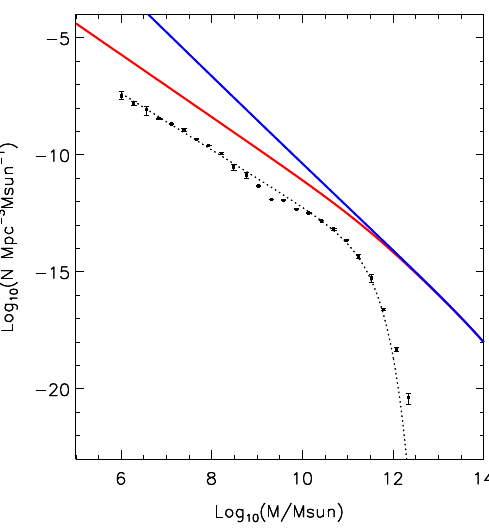
Fig. 37 The baryonic mass function of galaxies (data points). The dotted line shows a Schechter function fit to the data. The blue line shows the predicted mass function of dark matter haloes, assuming that dark matter is cold. The red line shows the same assuming that dark matter is warm with a (thermal relic) mass of m WDM = 1